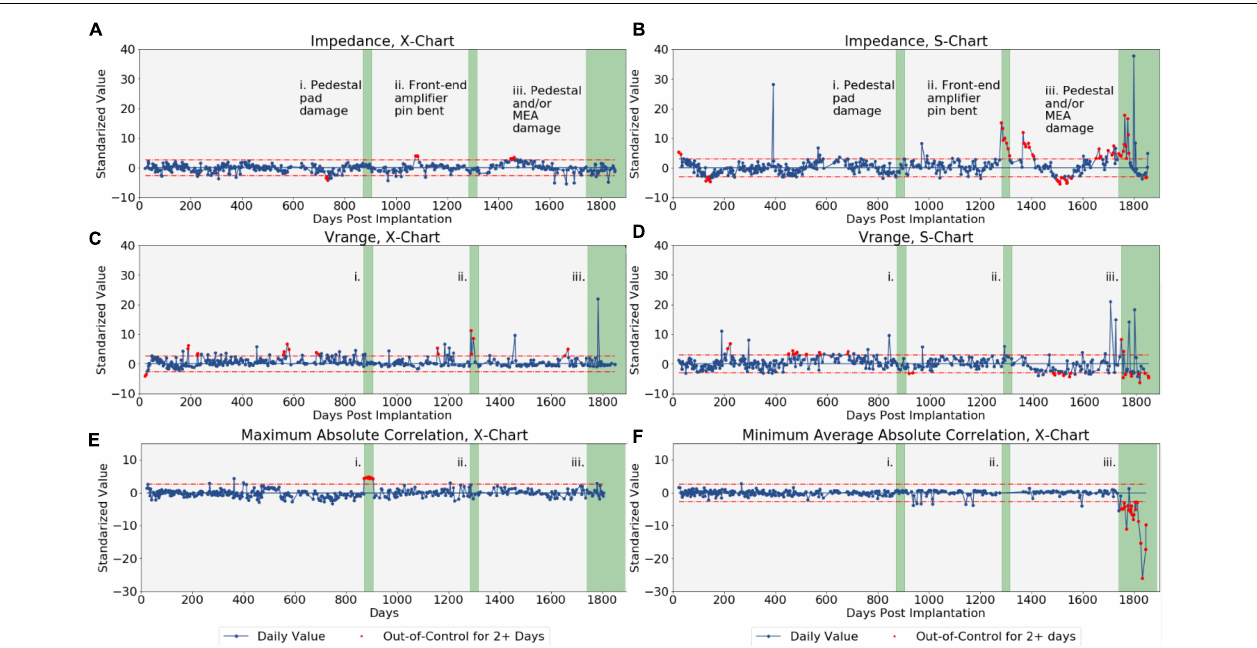
FIGURE 2 | The control charts produced for each of the four array-level metrics monitored by the statistical process control-based algorithm. Both X and S-charts were produced for impedance and voltage range, while only X -charts were produced for the correlation metrics. Dotted red lines represent control limits. The red points indicate metrics flagged for having been out-of-control for at least two consecutive sessions. The green regions represent periods of known damage. (A) Impedance X -chart. (B) Impedance S-chart. (C) V range X -chart. (D) V range S -chart. (E) Maximum absolute correlation X -chart. (F) Minimum average absolute correlation X